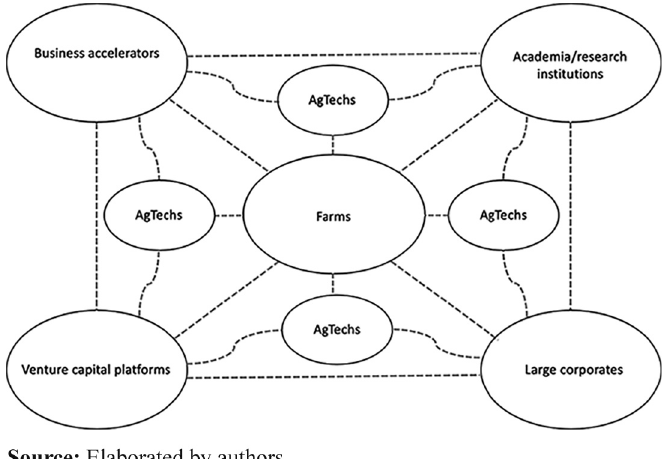
Figure 2. California ’ s agtech innovation